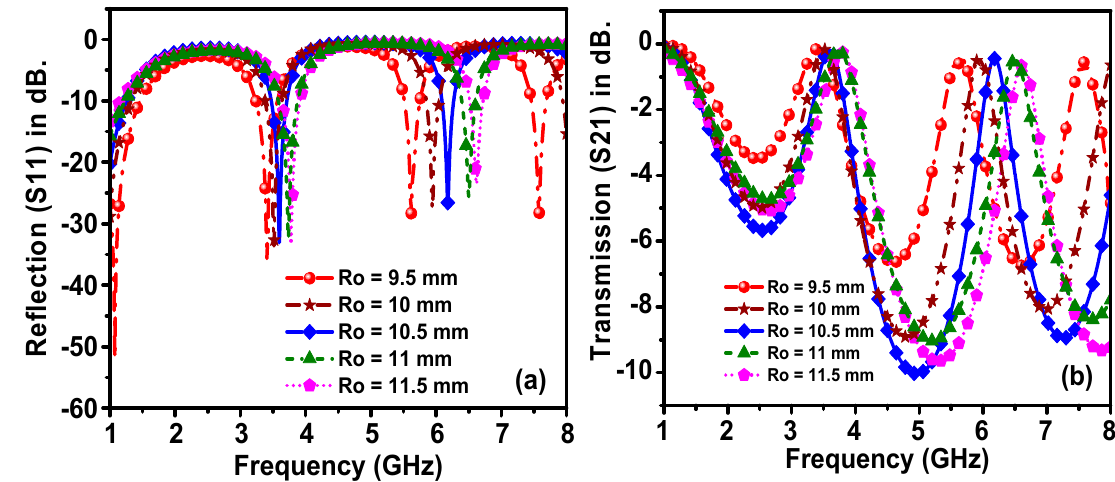
Figure 7. Effect of the width of the outer ring resonator radius on the resonant frequency of ( a ) reflection and ( b ) transmission spectra.